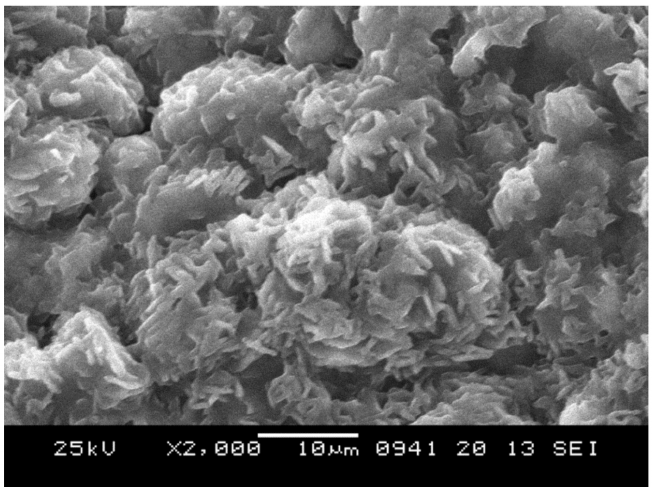
Figure 5. Scanning electron microscopy (SEM) micrograph of the Na 1.0 Li 0.2 Ni 0.25 Mn 0.75 O δ